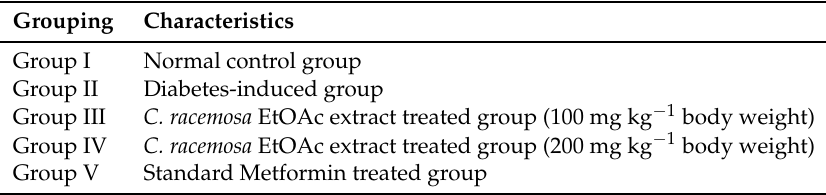
Table 1. Animals groupings used in assessing the antihyperglycaemic potentials of C. racemosa extracts.